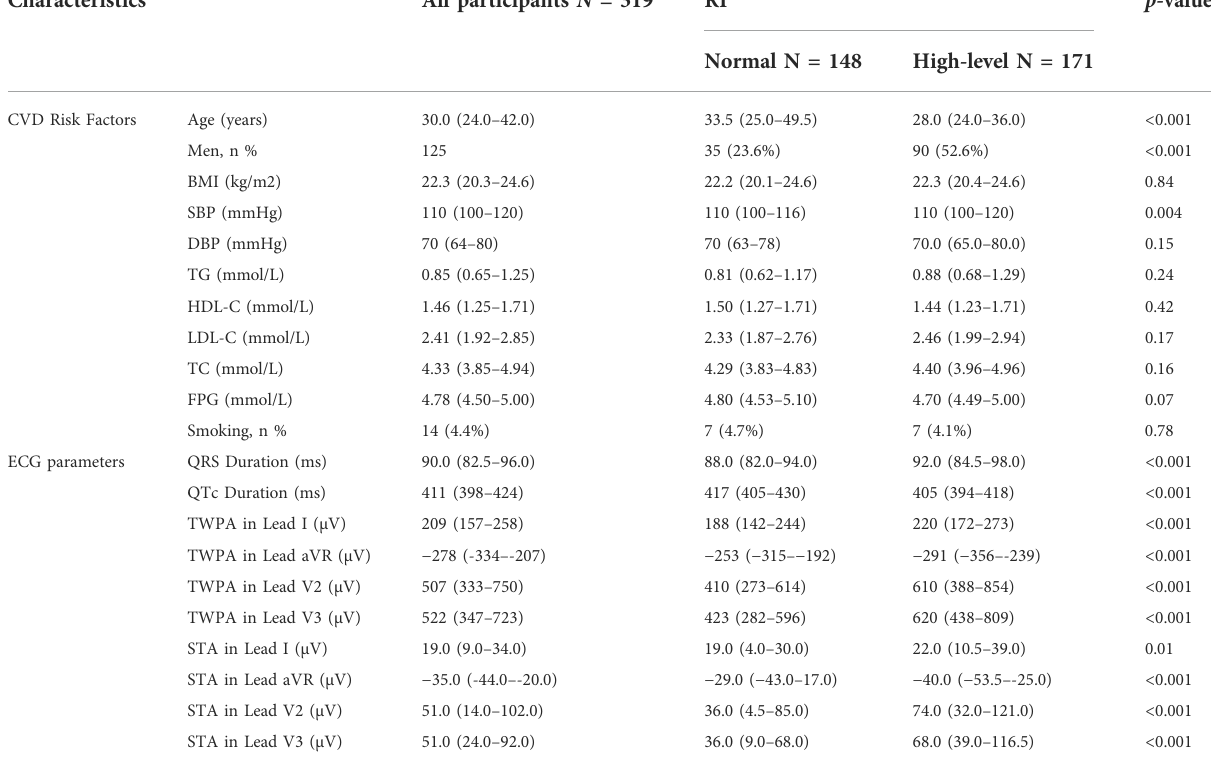
TABLE 1 Statistics of CVD risk factors and ECG parameters for participants in the normal RI group and the high-level RI group.